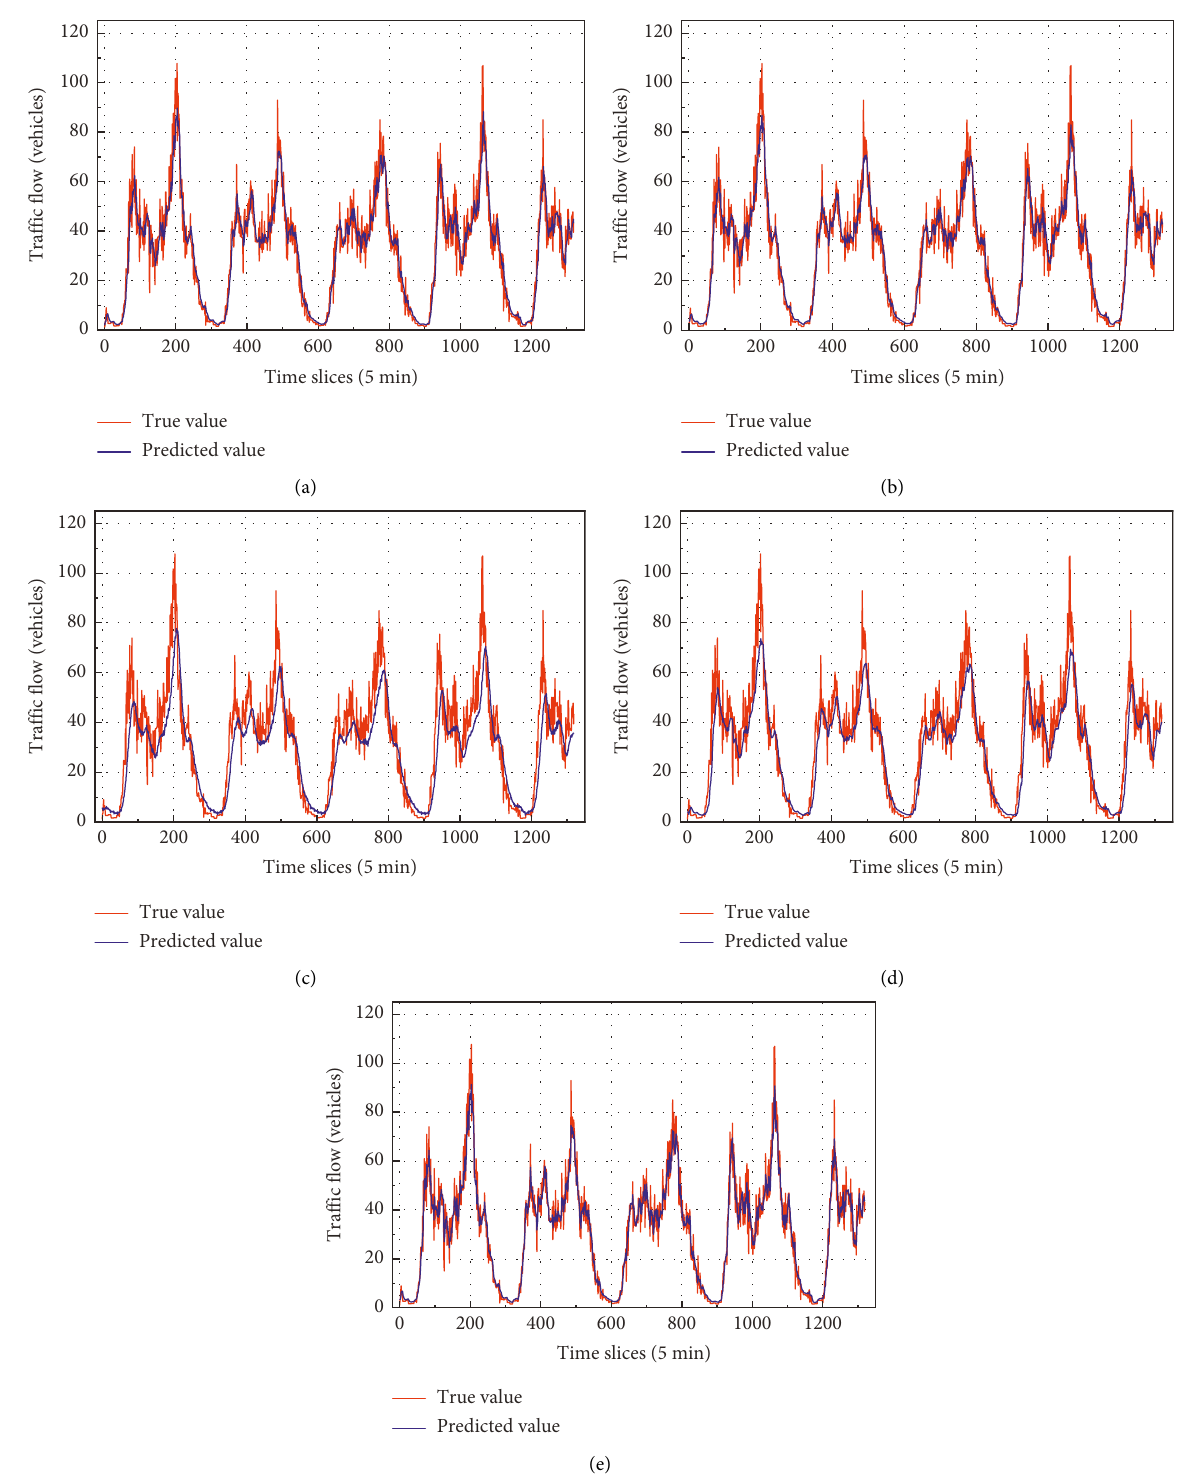
Figure 13: Prediction results of each model using the Hefei demonstration zone ITS dataset: (a) PDRGA-CDBN-LSTM; (b) CDBN-LSTM; (c) CDBN; (d) LSTM; and (e) PDRGA-CDBN-LSTM (noisy